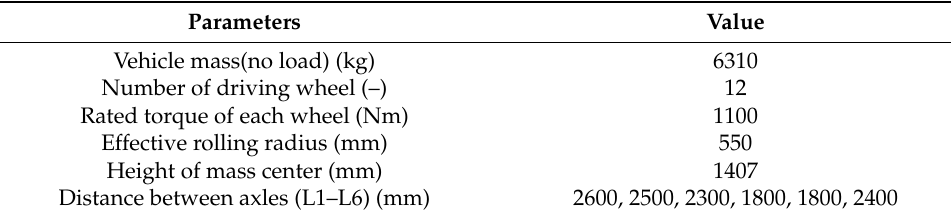
Table 1. Parameters of the 12 × 12 MADD vehicle model. Parameters